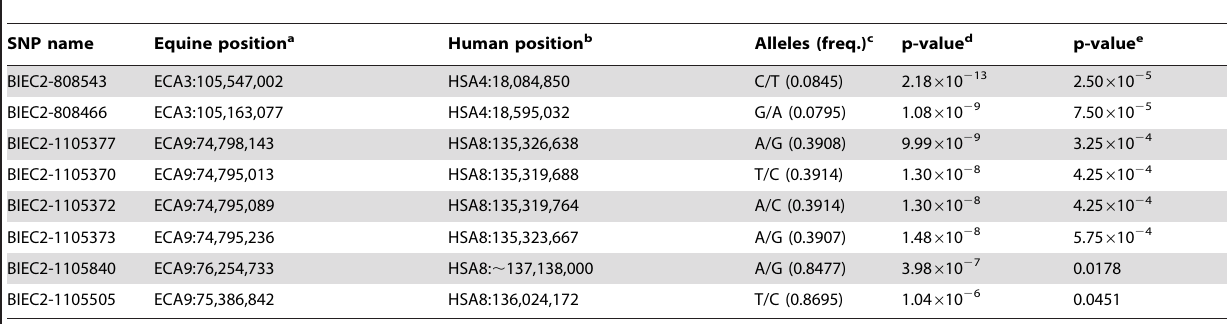
Table 2. Significantly associated SNPs with dEBV for height at withers using a mixed-model approach.